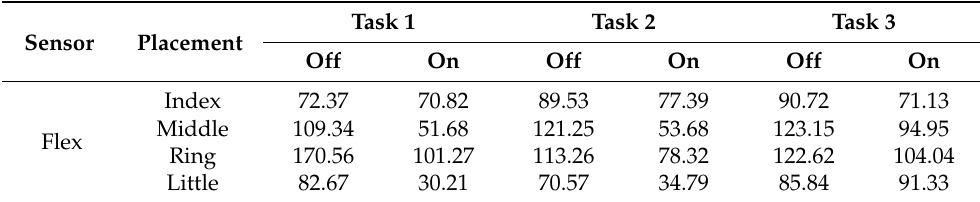
Table 4. Soft robotic glove validation experiment SD